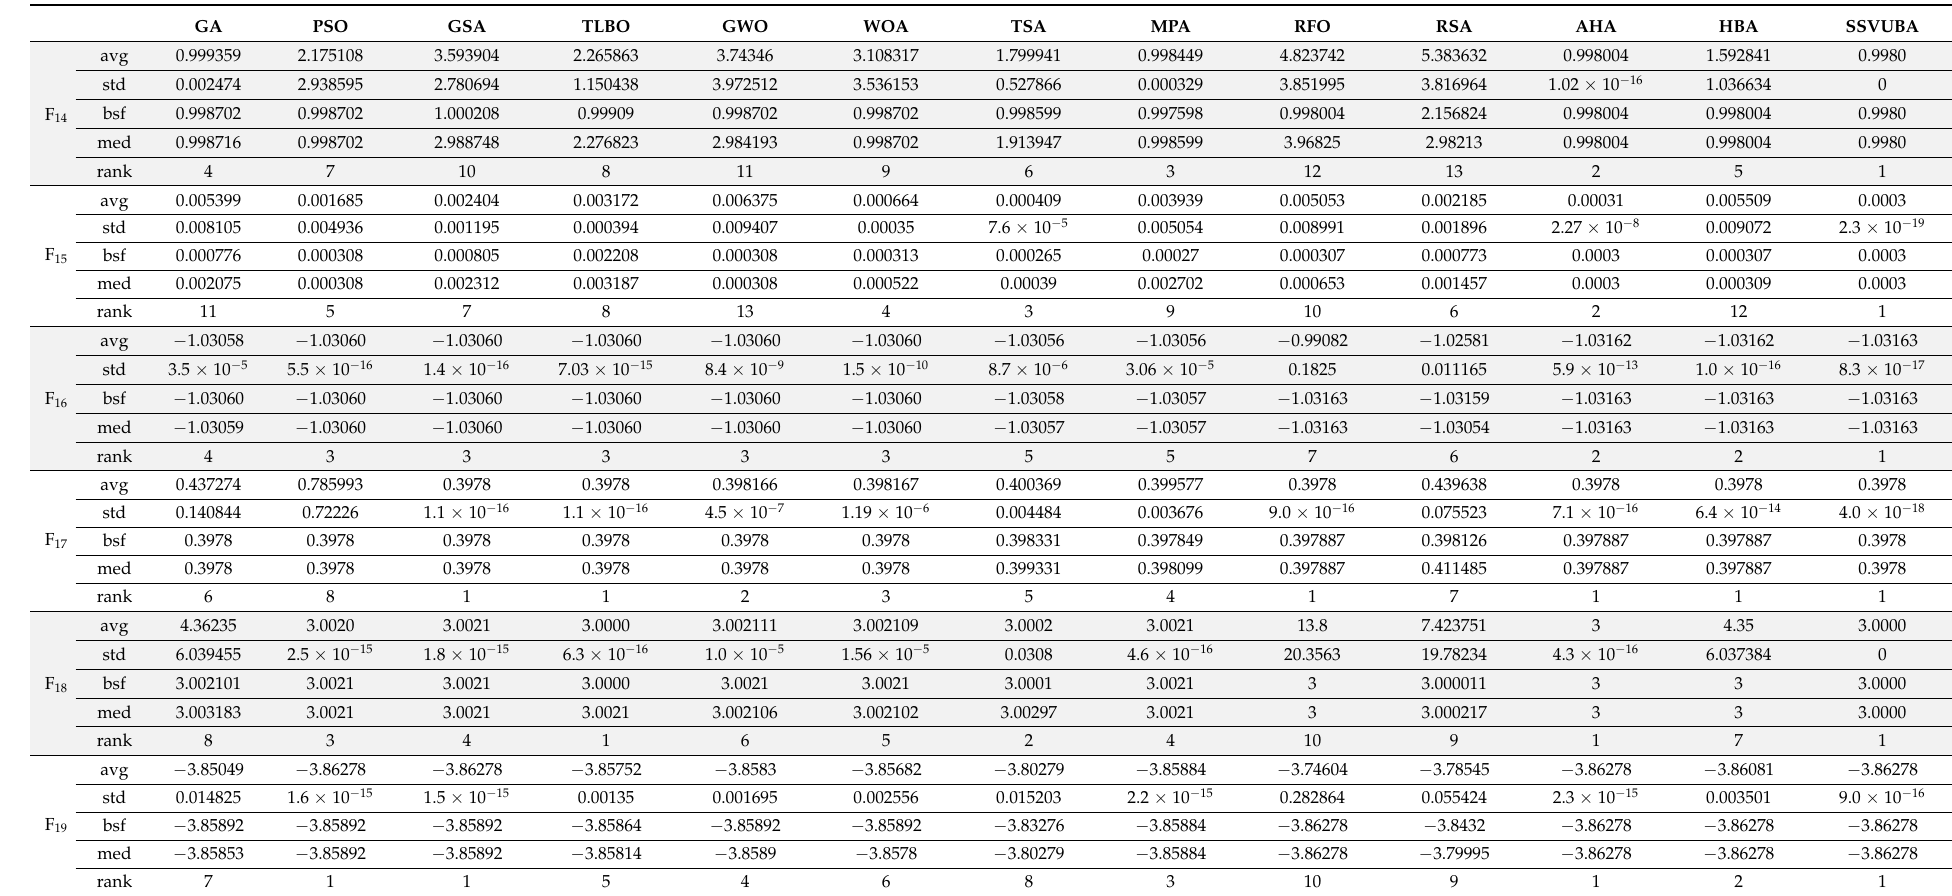
Table 4. Assessment results of fixed-dimensional multimodal